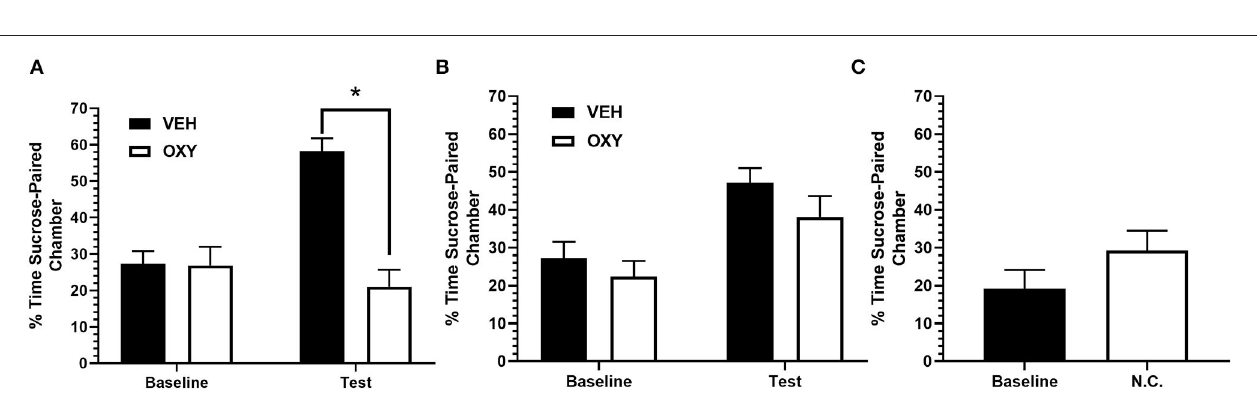
FIGURE 1 | Experimental timeline and pharmacological manipulation in (A) Experiment 1a (B) Experiment 1b (C) Experiment 1c. Sucrose-conditioning sessions were counterbalanced in Experiment 1a and 1b. In Experiment 1b, animals in the OXY treatment group received OXY injections only prior to sucrose-paired conditioning sessions. Animals in Experiment 1c received no access to sucrose pellets during conditioning or any injections of OXY or VEH. VEH = Vehicle; OXY = Oxytocin.